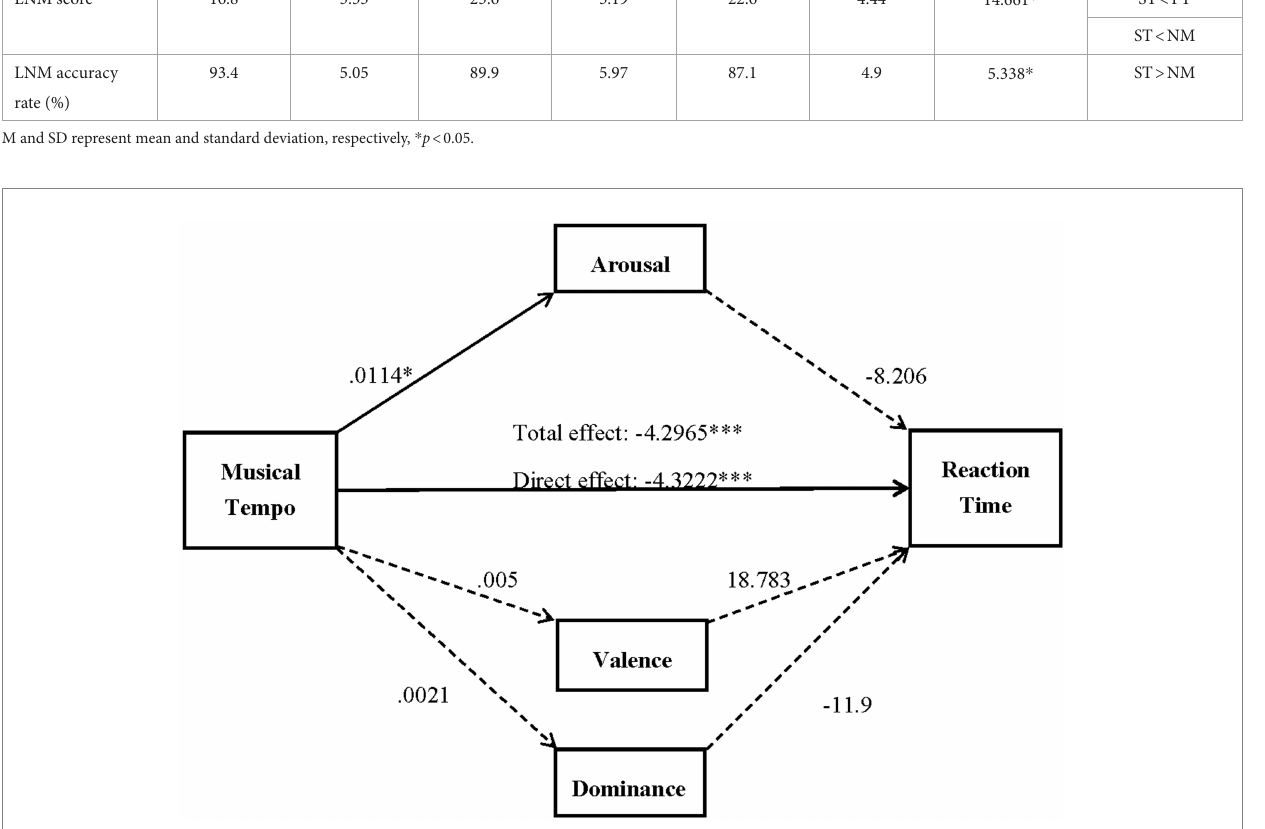
FIGURE 5 Unstandardized coefficients of the mediation model. * p < 0.05, ** p < 0.01, and *** p <